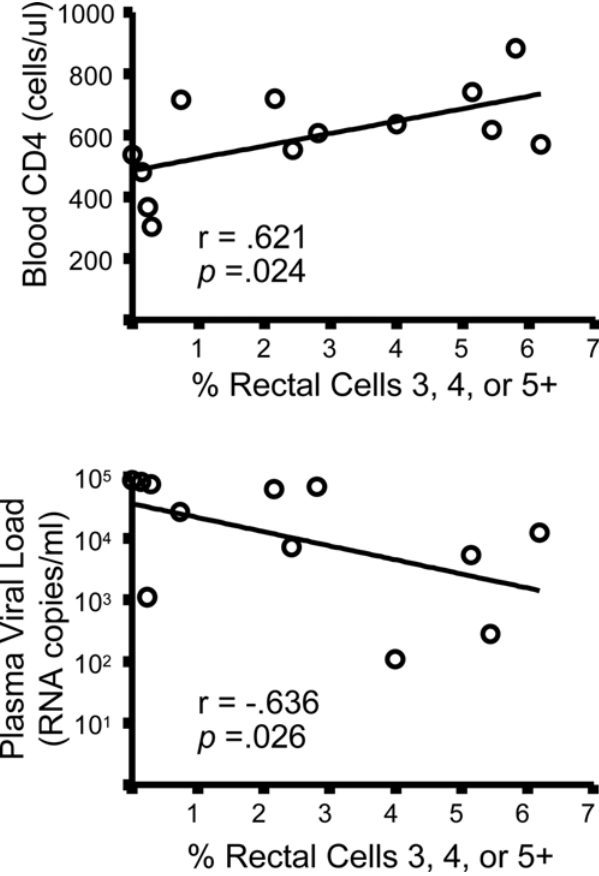
Figure 6. Correlation (Spearman) of polyfunctional rectal CD8 + T-cell responses and plasma viral load or blood CD4 count. Polyfunctionality was defined as the summed frequencies of the 5 + and predominant 4 + & 3 + groups (as shown in the bar graph, Fig. 4). This derived value was plotted (X-axis) against blood CD4 count or plasma viral load (Y-axis). Results for r and level of significance are shown. Comparable relationships between PBMC polyfunctional responses and clinical parameters are not shown, as they were not statistically significant.